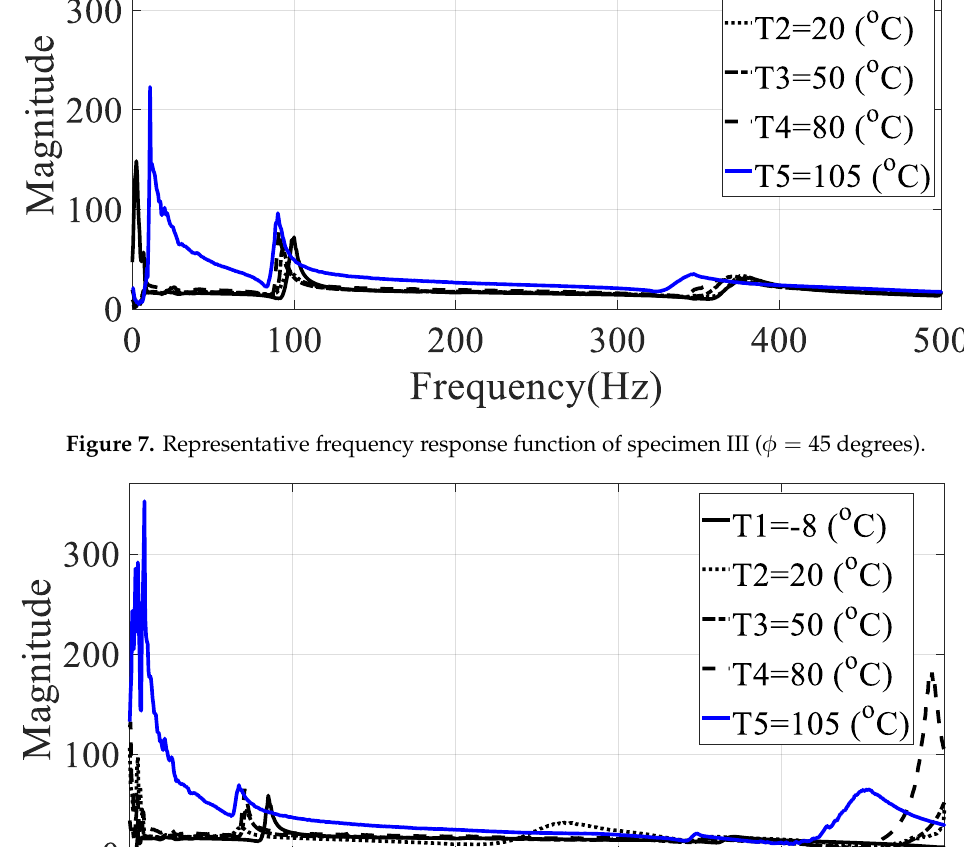
Figure 8. Representative frequency response function of specimen IV ( 𝜙 = 60 degrees ).